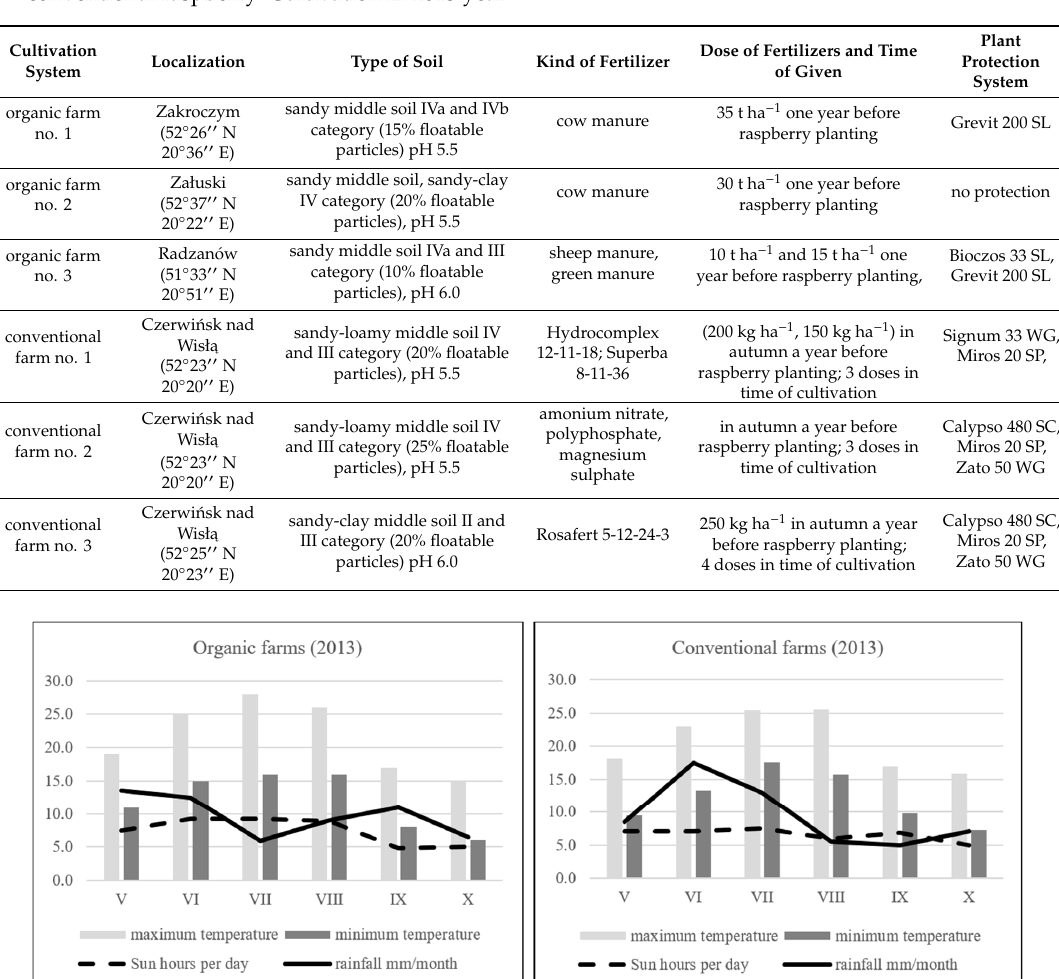
Table 1. Characterization of localization, fertilizers regime and plant protection used for organic and conventional raspberry. Cultivation in 2013 year.